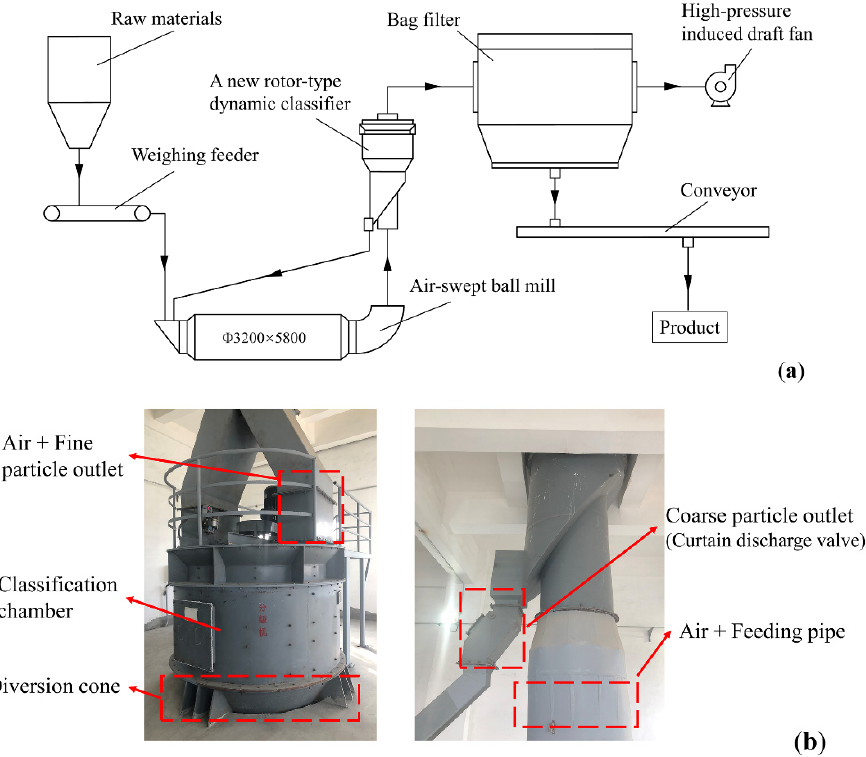
Figure 27. ( a ) Process flow diagram of the grinding and classifying system and ( b ) photo of the industrial classifier.